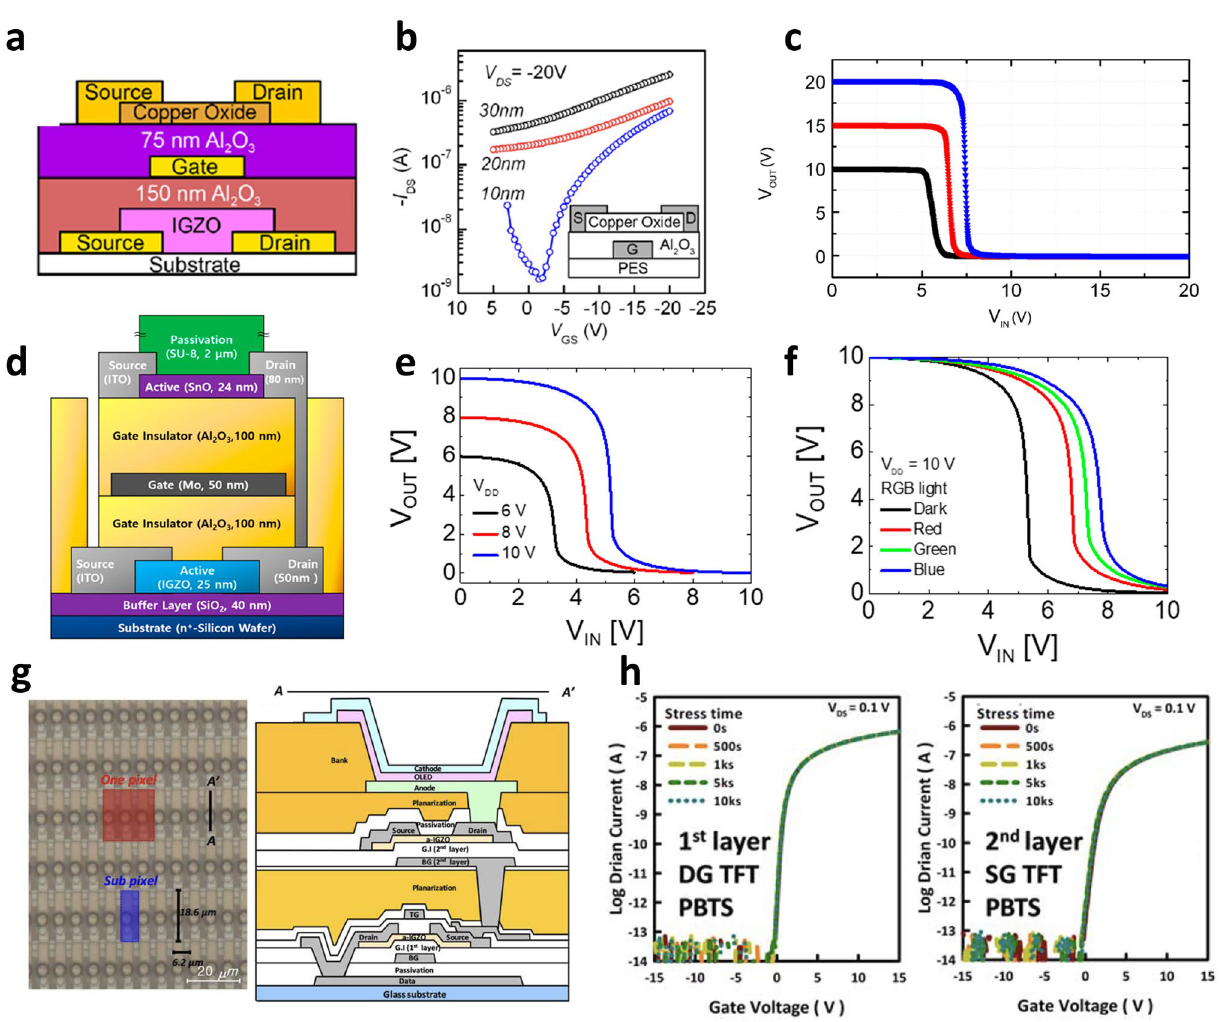
Fig. 4 a Schematic diagram of a complementary inverter in which a p-type copper oxide transistor is vertically stacked on top of an n-type α -IGZO transistor. b Transfer curve of CuO TFT when CuO thickness is 10, 20, and 30 nm. c Voltage transfer characteristics of a vertically stacked inverter composed of a copper oxide transistor and an α-IGZO transistor [24]. Copyright © 2011, AIP Publishing. d A schematic of vertically stacked complementary inverter composed of a p-type SnO and an n-type IGZO TFTs. e Voltage transfer characteristics of a comple- mentary inverter in which n-type IGZO TFT and p-type SnO TFT are vertically stacked when V DD is 6, 8, and 10 V. f Change in the inverter characteristics according to red, green, and blue light application [25]. Copyright © 2019, MDPI. g Optical image and cross-sectional schematic of vertically stacked metal oxide TFT arrays for high-resolution active-matrix organic light-emitting diode backplanes. h PBTS measurement results for switching and driving TFTs, which are the first and second TFT layers for the backplane realization of high-resolution TFTs